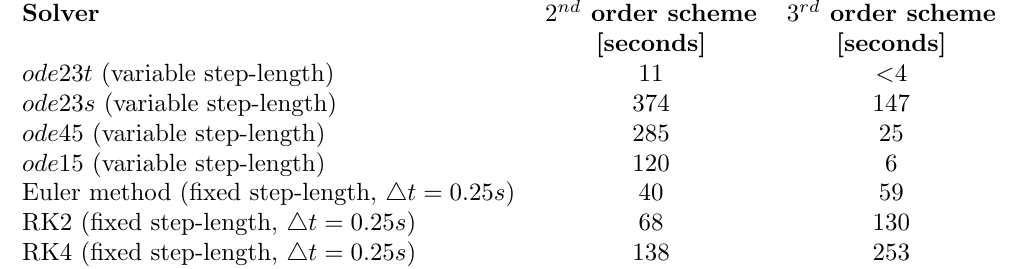
Table 2: Computational time required for the 2 nd and 3 rd order KP scheme.